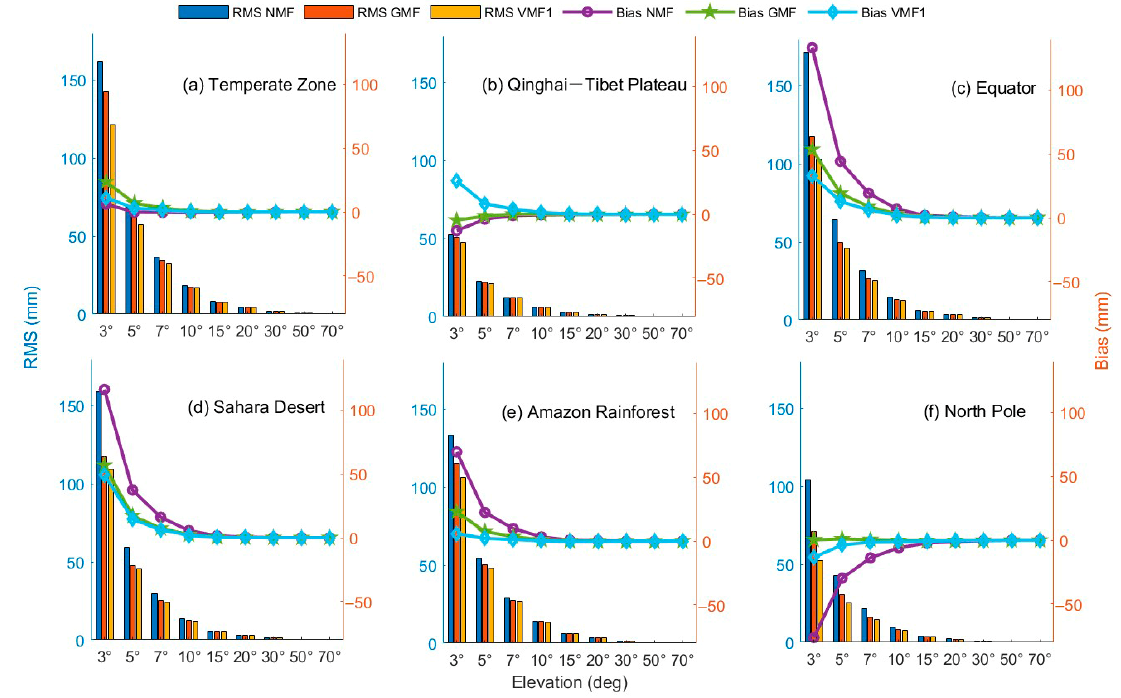
Figure 3. The root-mean-squares (RMSs) and biases of the NMF, GMF, andVMF1 for the six regions at the nine elevations (70°, 50°, 30°, 20°, 15°, 10°, 7°, 5°, and 3°): ( a ) Temperate Zone ( b ) Qinghai–Tibet Plateau ( c ) Equator ( d ) Sahara Dessert ( e ) Amazon Rainforest ( f ) North Pole.